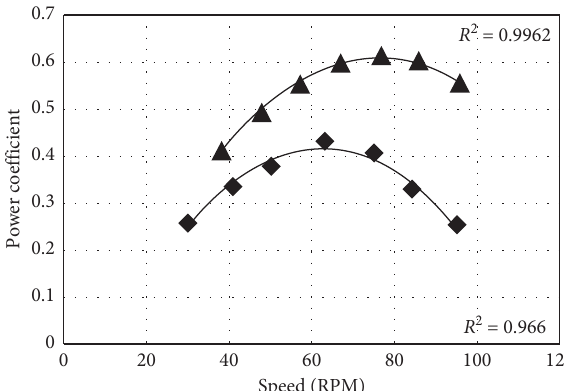
Figure 35: Runner 18 data points.